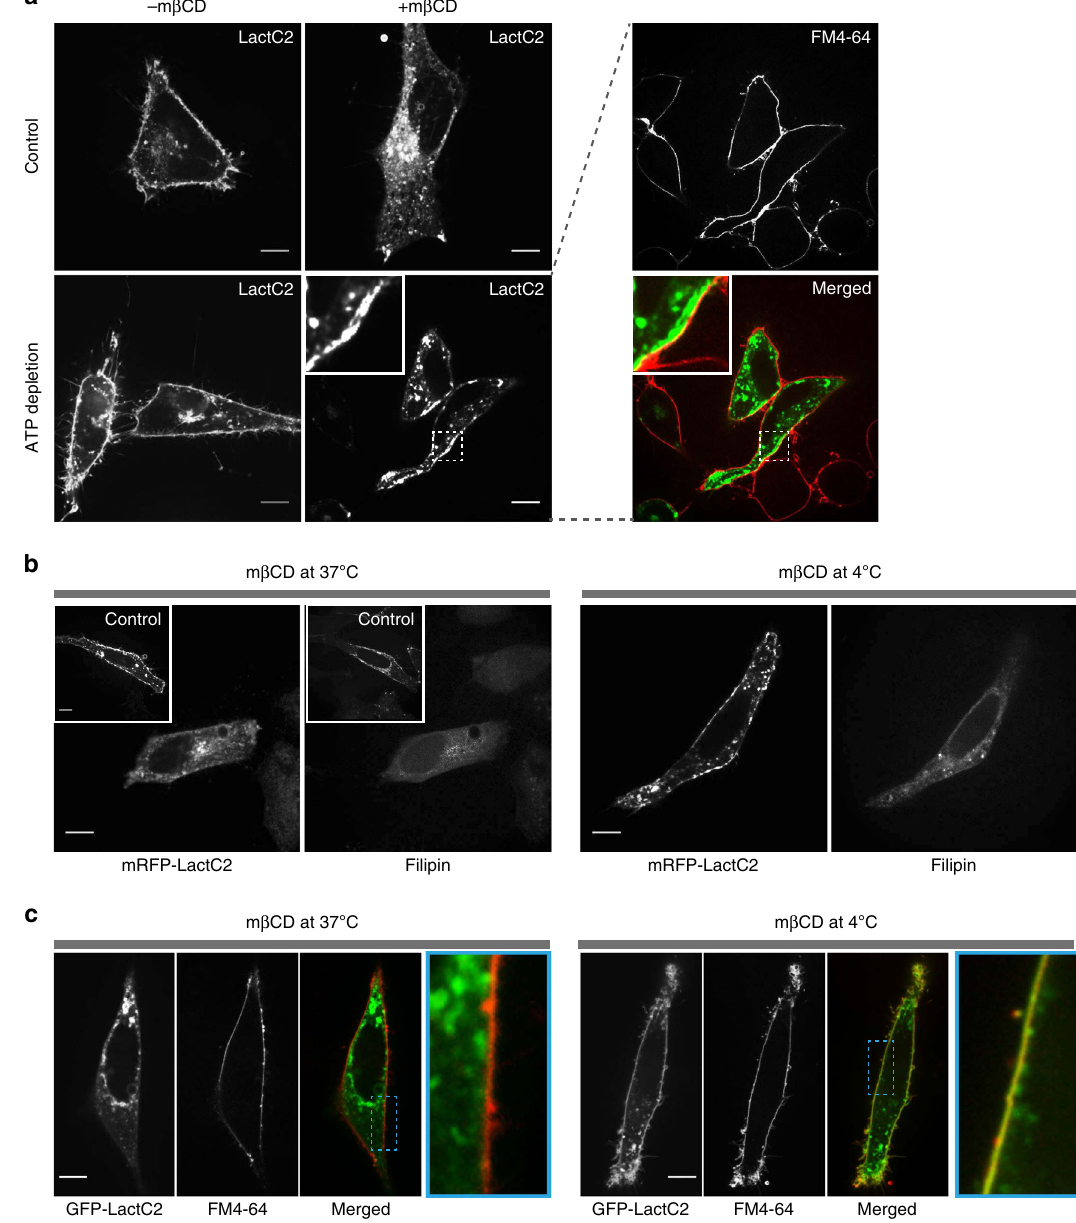
Fig. 2 PtdSer internalization is ATP independent. a Representative images of HeLa cells expressing GFP-LactC2 treated with 10 mM m β CD for 30 min with or without ATP depletion, which was carried out pretreating cells with 0.2 µ M antimycin A and 10 mM 2-deoxy-D-glucose for 60 min in Ca 2+ -free and glucose-free medium. After m β CD treatment, cells were labeled with 40 ng/ µ L FM4-64. b Cholesterol extraction using m β CD was performed at 4 °C or 37 °C, as indicated, followed by fi xation with 4% paraformaldehyde and labeling with 0.05% fi lipin. Inset: control cells without cholesterol removal. c m β CD was removed after 30 min and GFP-LactC2-expressing cells were labeled with FM4-64. Inset: magni fi cations of the area indicated by a dashed square. Scale bar = 10 µ m in all